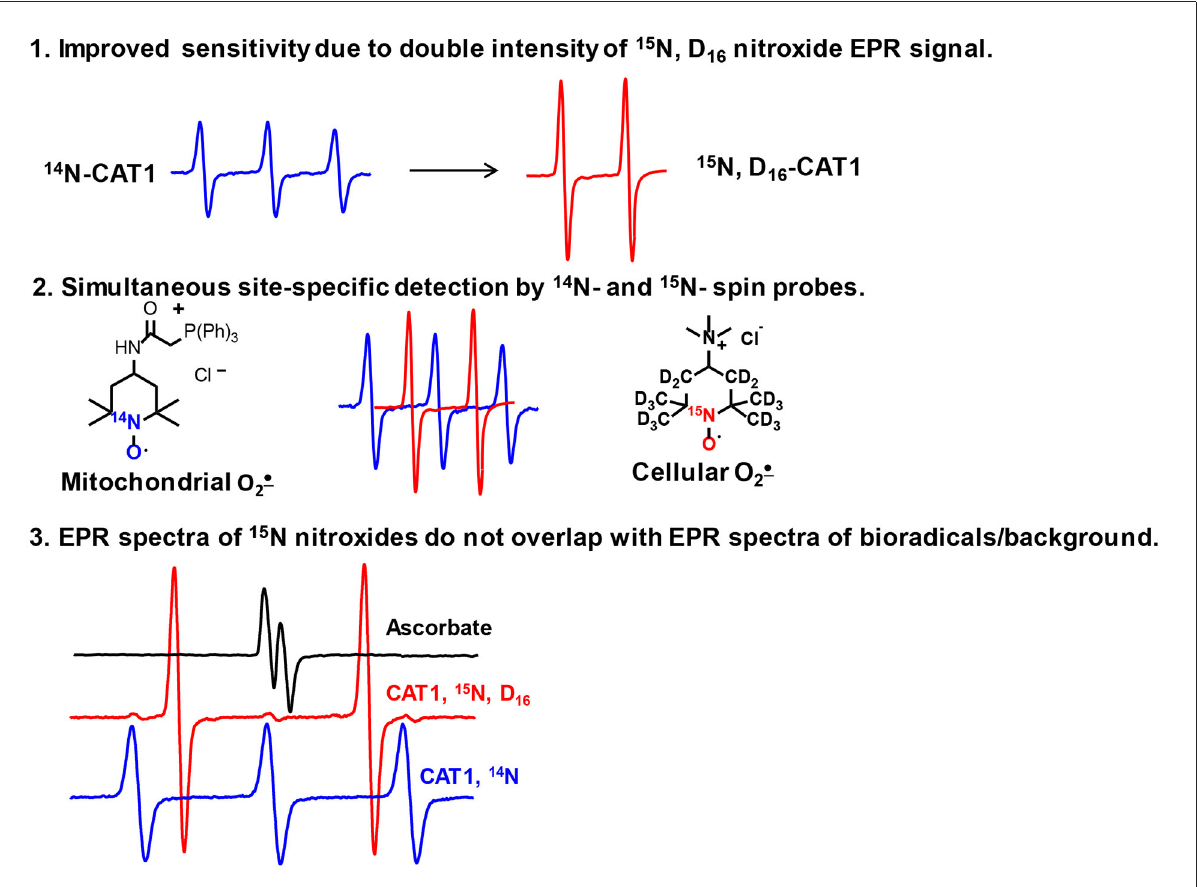
FIGURE5 Advantages of 15 N- and deuterium-enriched hydroxylamine spin